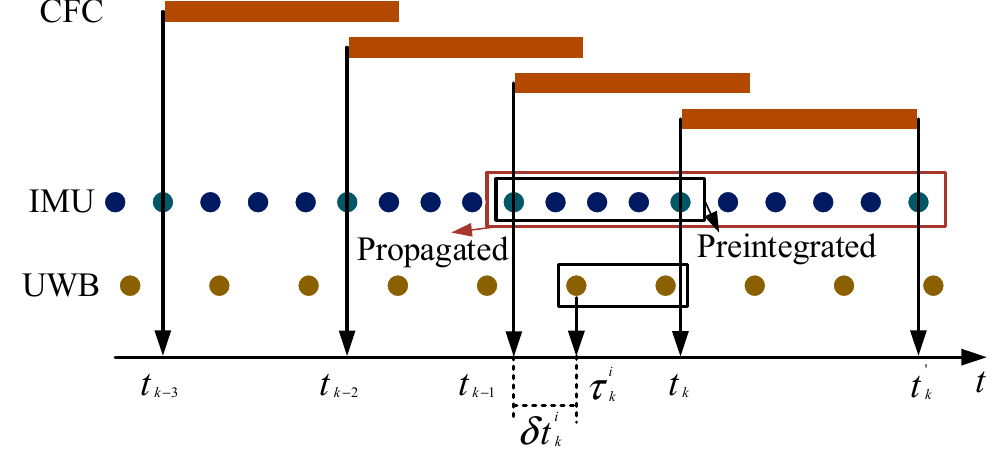
Figure 1. Synchronization between the CFC, UWB, and IMU.